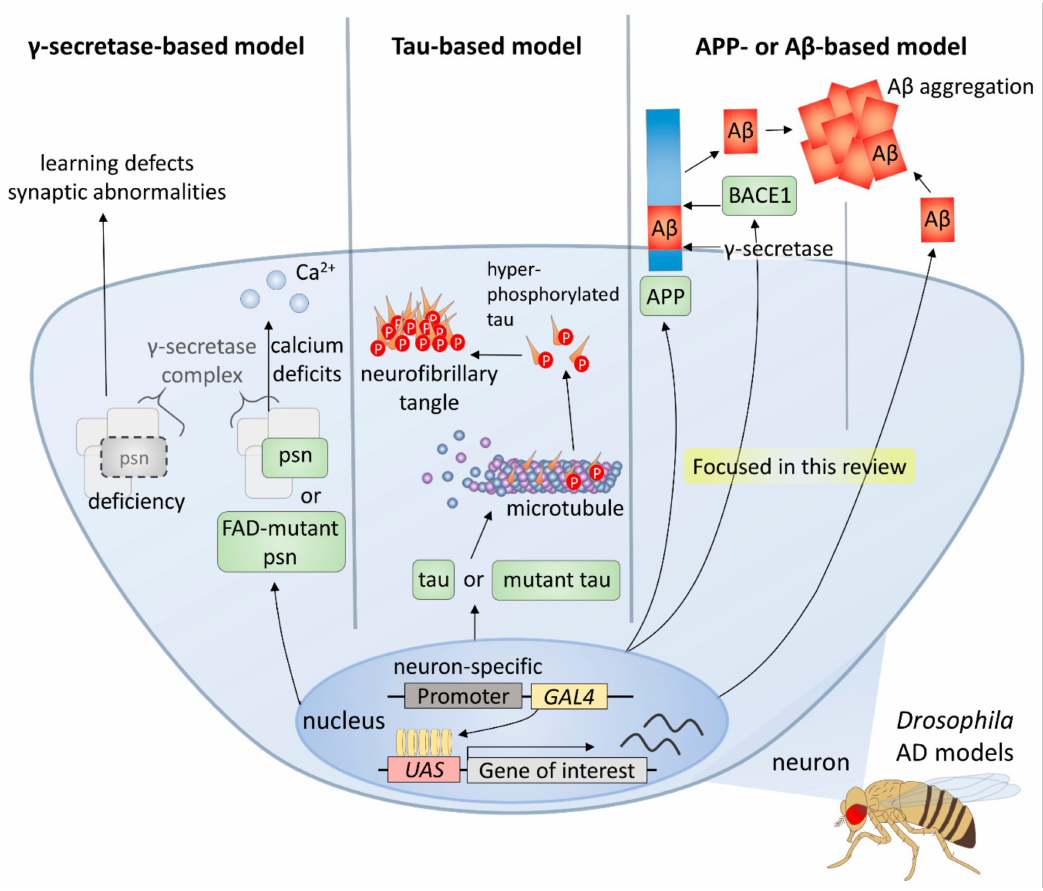
Figure 1. Drosophila models for Alzheimer’s